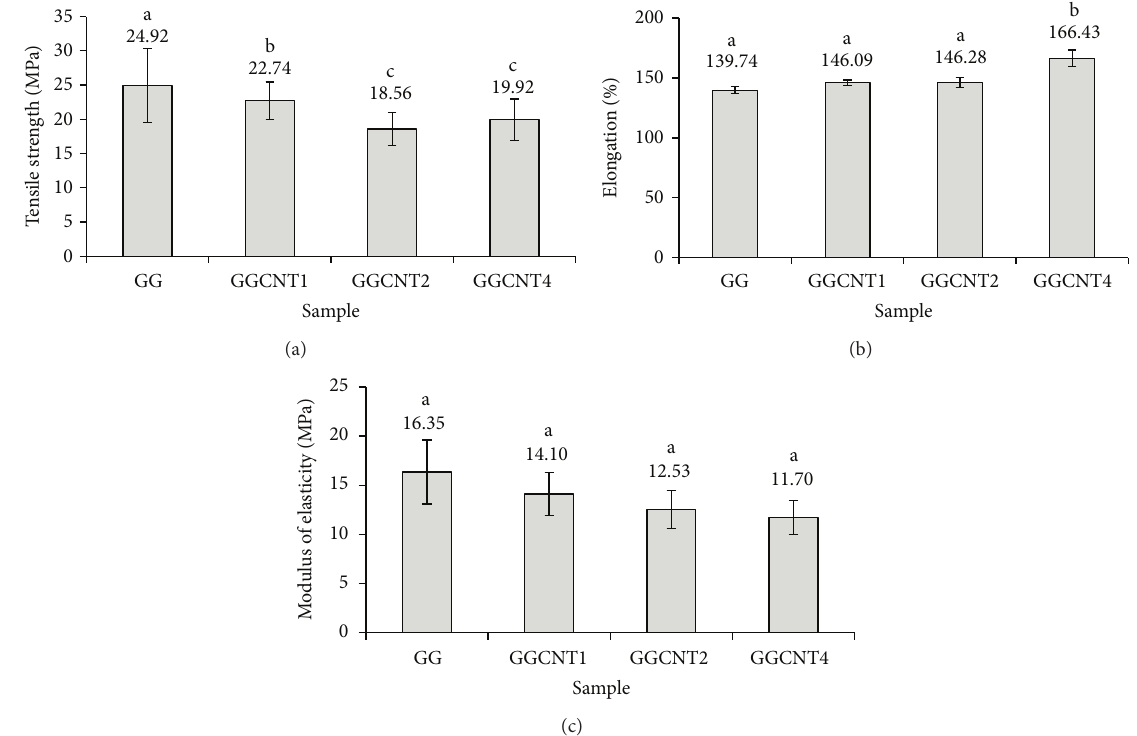
Figure 4: Mechanical properties of films from gelatin/glycerol and carbon nanotubes. Error bars with the same letter are not significantly different ( 𝑃 > 0.05 ).